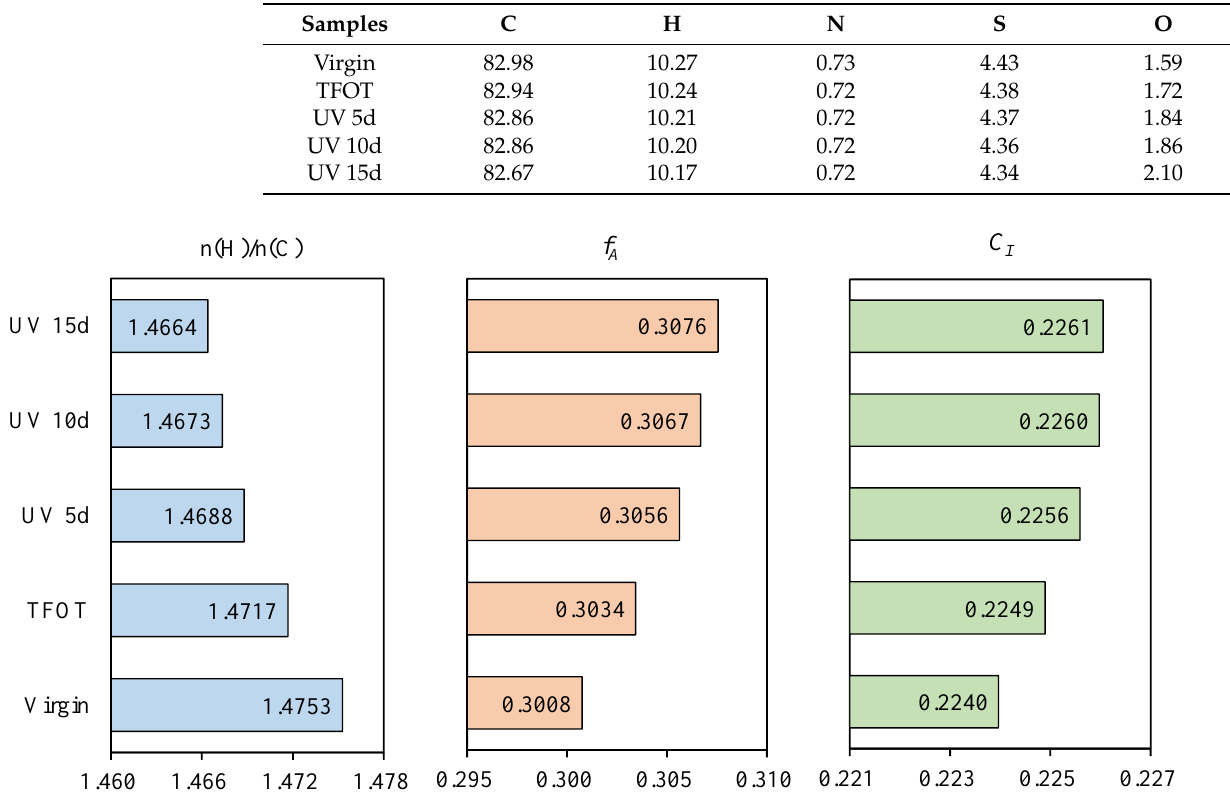
Figure 6. Important indexes (n(H)/n(C), f A and C I ) of asphalt after the multiple aging of heat and UV.